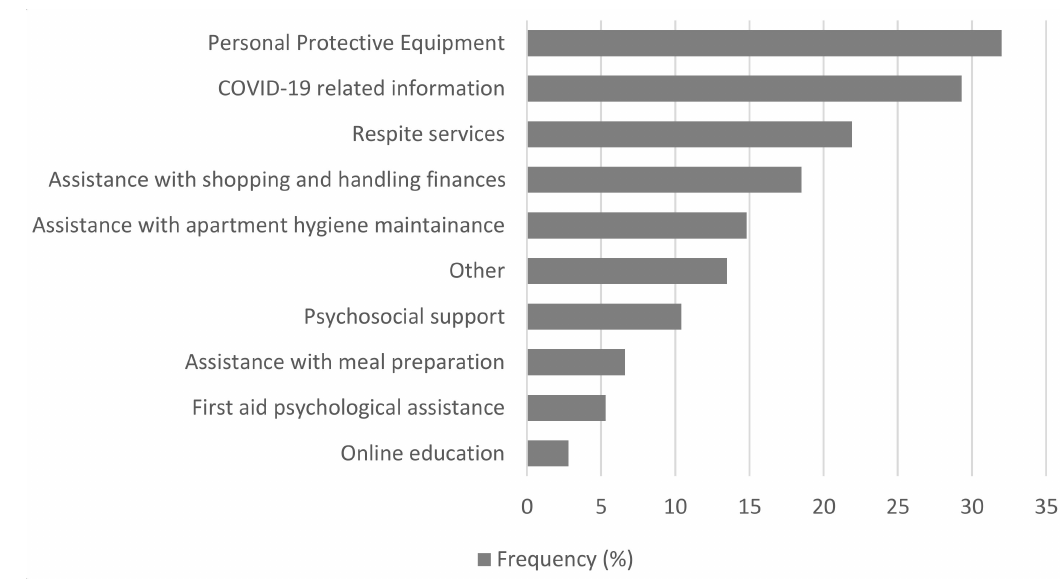
Figure 1. Needs of informal caregivers during the COVID-19 epidemic in Serbia. More than half (61.5%) of informal caregivers believed that their health was more at risk than before the pandemic. More than two-thirds (68.7%) believed that during the pandemic the health of the person they were caring for was more at risk than before the pandemic, and 67.3% were concerned more for their own or for the health of the person being cared